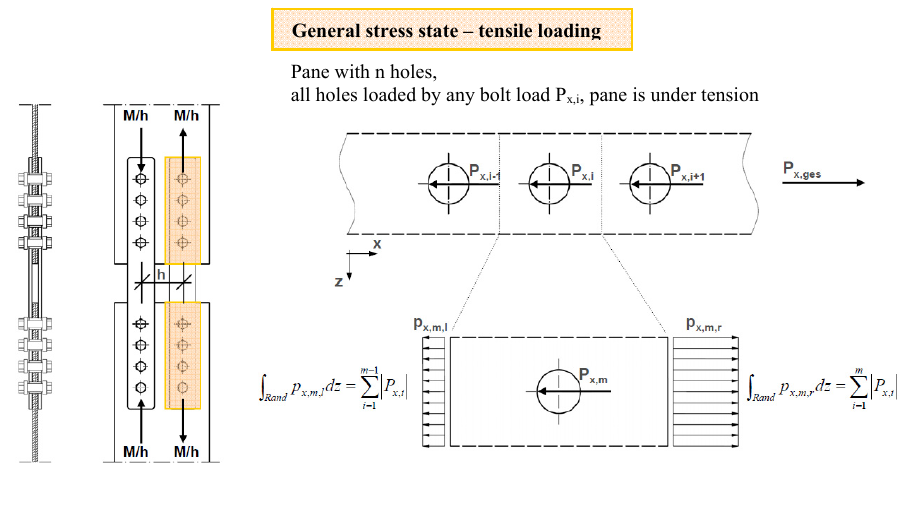
Figure 3: Joint loaded by a moment, free of shear force.